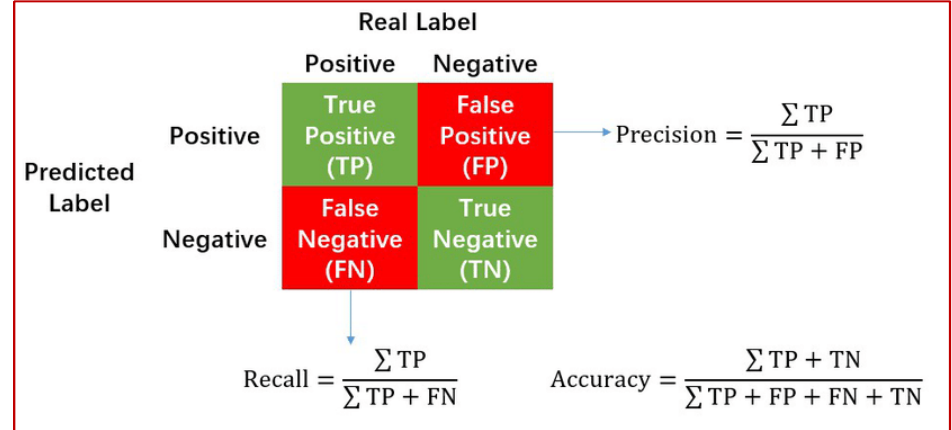
Figure 11. Confusion Matrix Analysis for predictive models using ODT: ( a ) Classification System and ( b ) Detection Sys- tem.